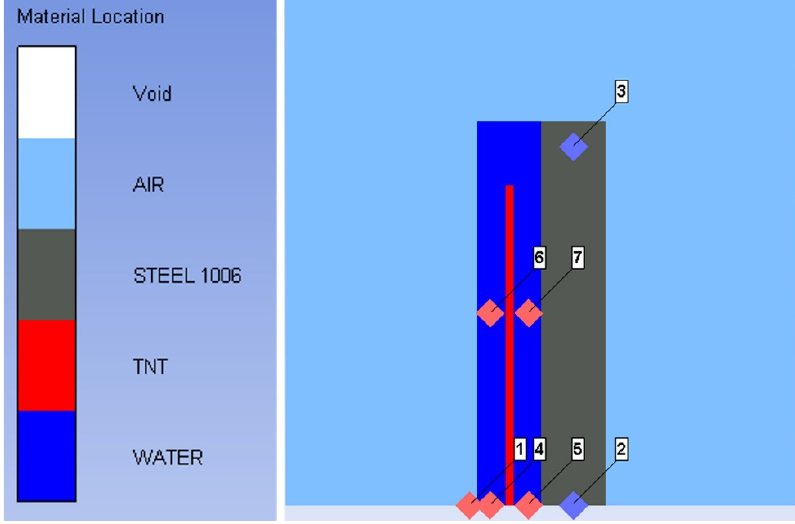
Figure 7. Simulation gauge locations.